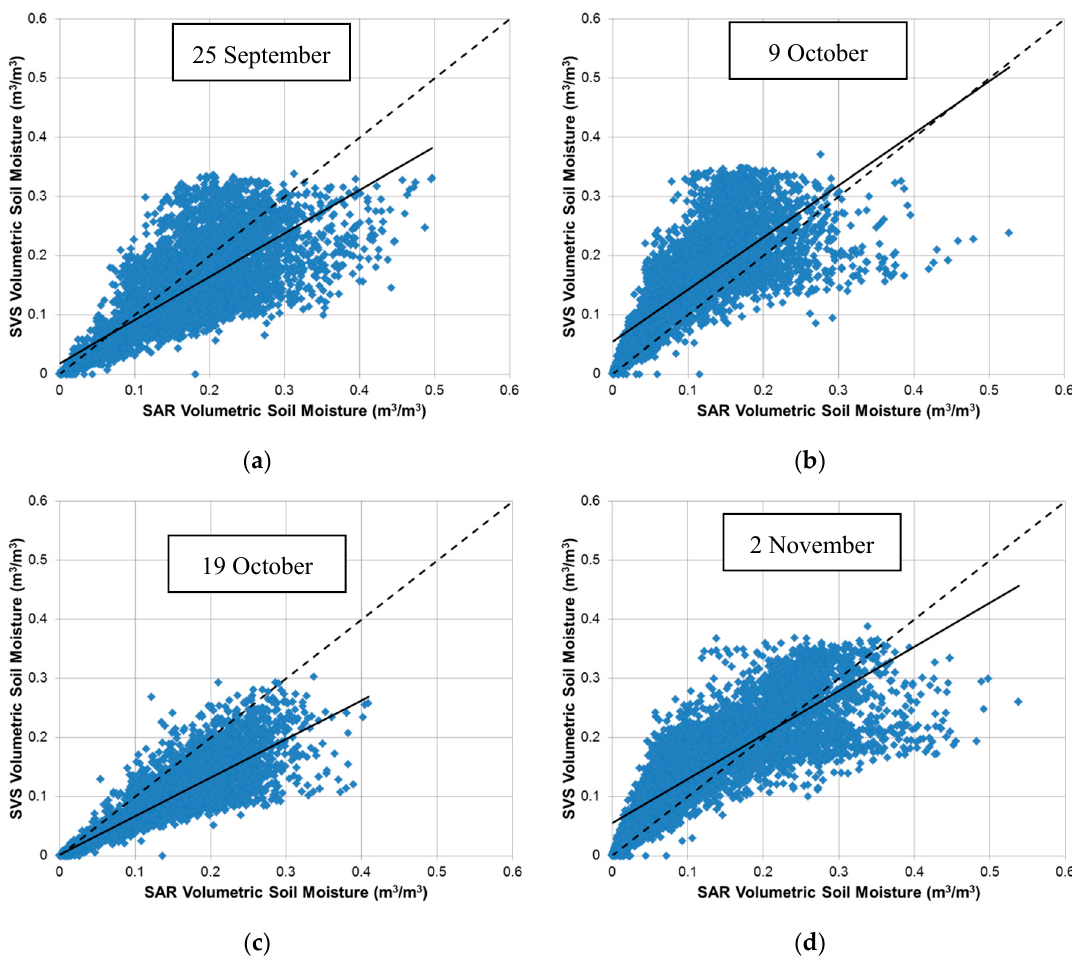
Figure 9. Scatterplots of the modeled (SVS) and estimated (SAR) soil moisture for ( a ) 25 September, ( b ) 9 October, ( c ) 19 October, and ( d ) 2 November. The dashed line represents the 1:1 line and the solid line is the regression line between modeled and estimated soil moisture. Each dot represents the average soil moisture modeled (SVS) and estimated (SAR) of each soil polygon.